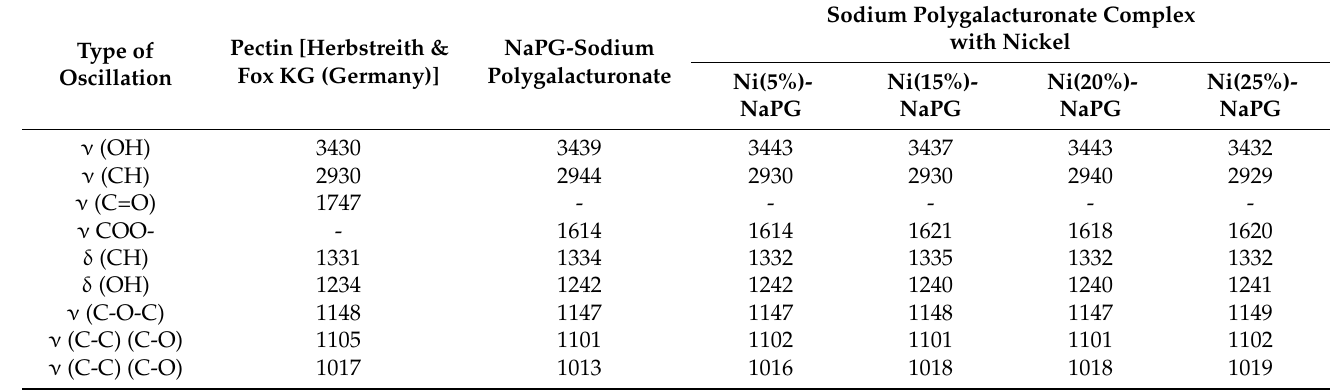
Table 1. The positions of the maxima of the IR spectra main characteristic bands (cm − 1 ) of the pectin, sodium polygalacturonate and sodium polygalacturonate complexes with nickel.